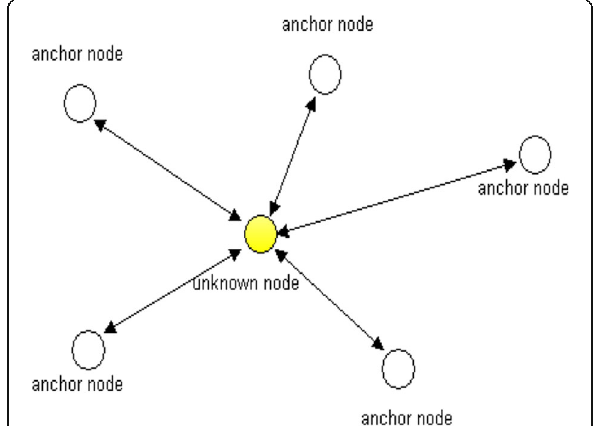
Fig. 2 Unknown node location diagram, wherein the anchor node (anchor node) is a static node location that is known, the unknown node is a dynamic node, and the other around the anchor node receives coordinate data to calculate its own position